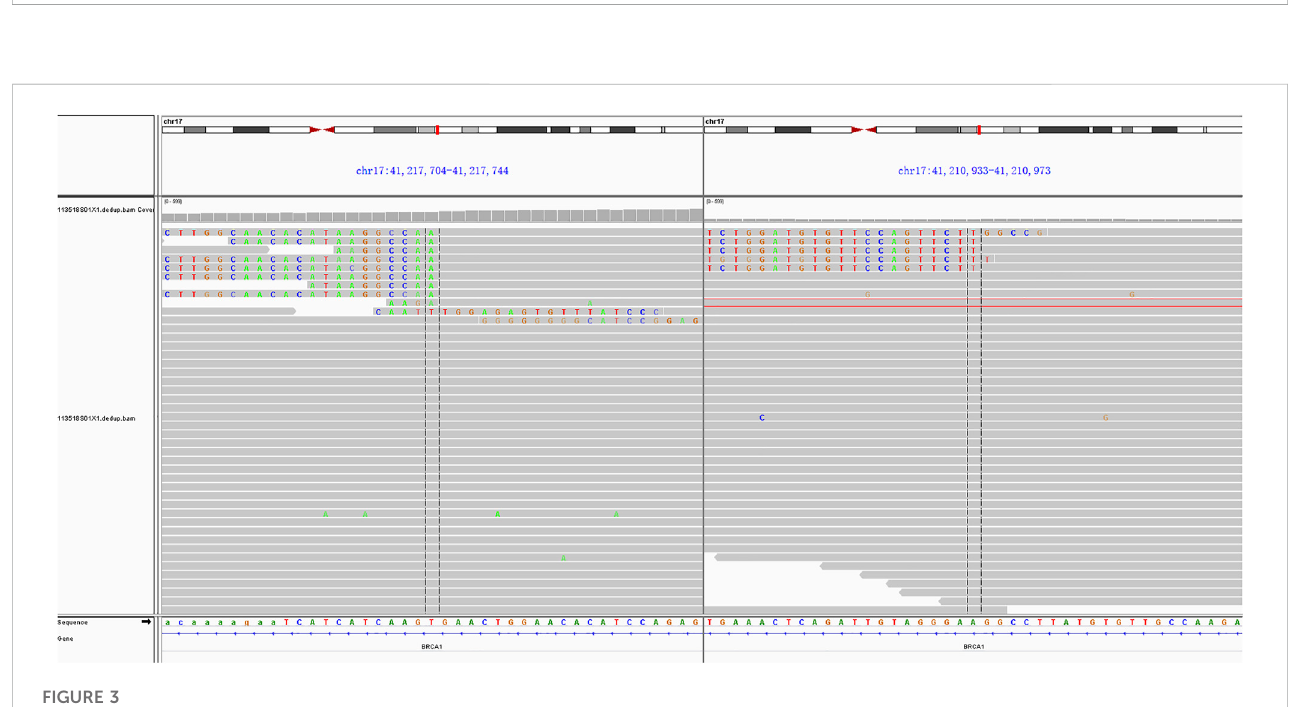
FIGURE 3 NGS indicated a somatic mutation: somatic BRCA1 exon 17-18 inv.